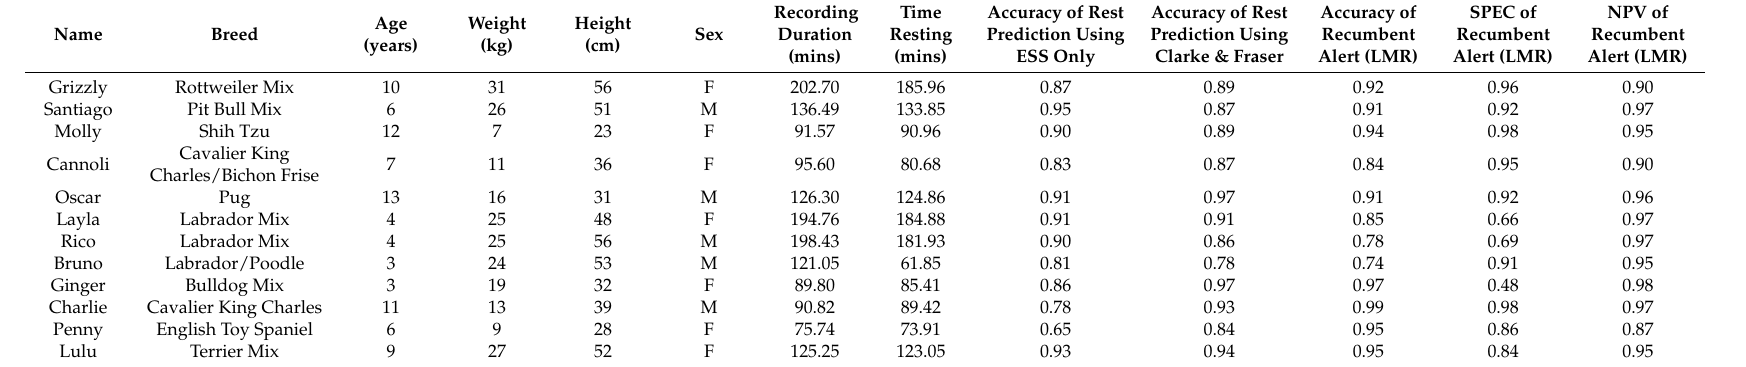
Table 1. Description of study participants and performance of the ESS, Clarke and Fraser, and LMR